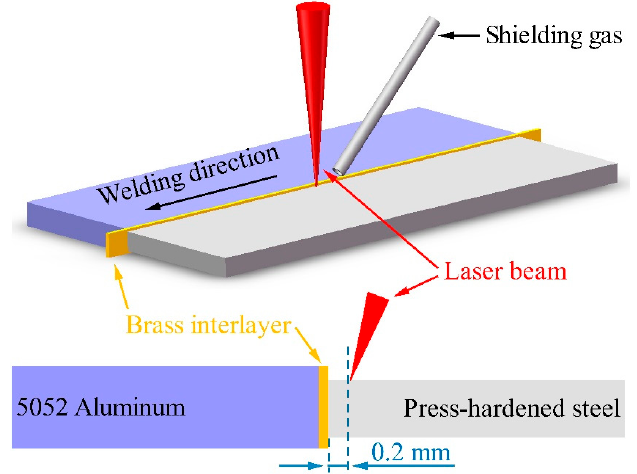
Figure 2. Schematic diagram of the laser offset welded aluminum to press-hardened steel with a brass interlayer. brass